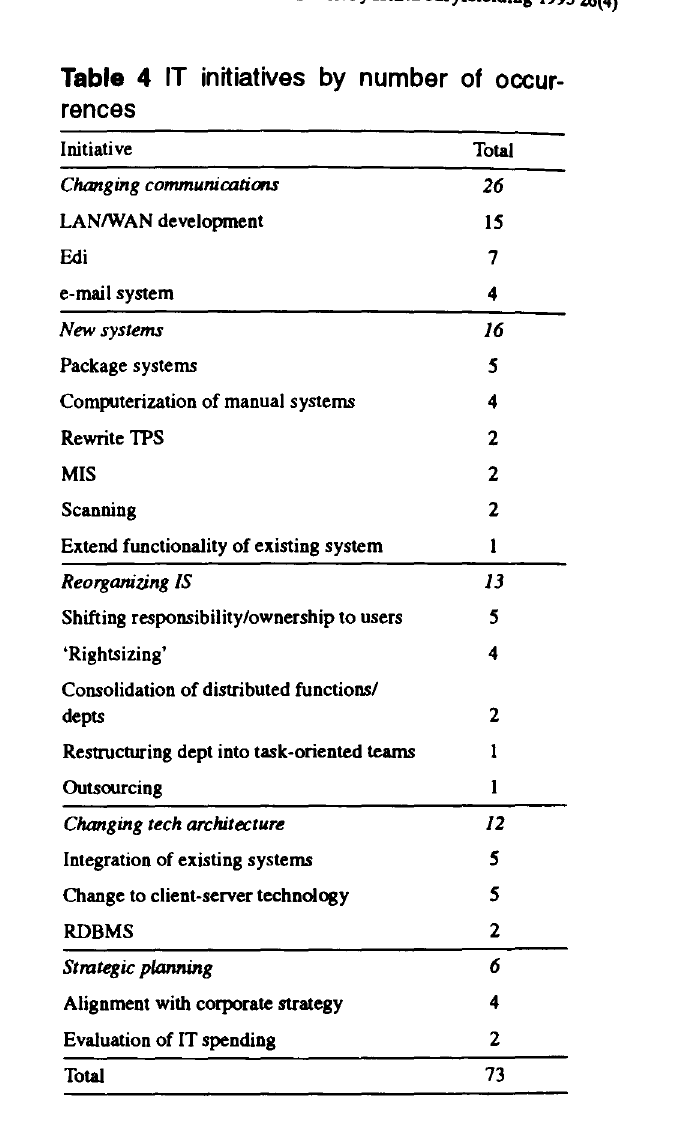
Table 4 IT initiatives by number of